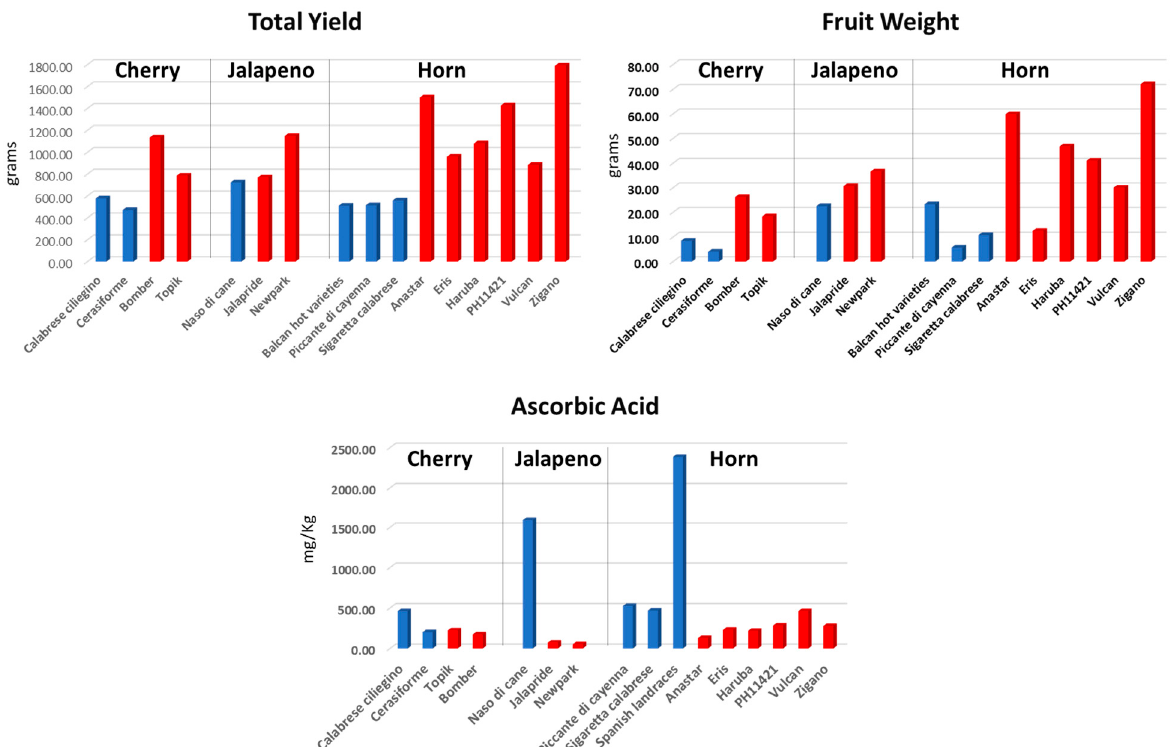
Figure 3. Bar graphs showing average values of total production, fruit weight and ascorbic acid content for the hybrids evaluated in this study (average of the two growing environments) compared with local cultivar investigations. For ‘Cal- abrese cherry’, ‘Cerasiforme’, ‘Piccante di Cayenna’ and ‘Cigaretta Calabrese’ the average values observed for the 2014–2016 seasons in the experimental fields of CREA of Battipaglia, Montanaso Lombardo and Monsampolo del Tronto [6,7,11] were considered. For the pungent cultivars from the Balkans, only the production data reported in [12] and related to the 2018–2019 seasons were considered. For Spanish cultivars, we considered the average ascorbic acid levels described in Rodríguez-Burruezo et al. [13]. All studies used the same method of assessment reporting values in the same scale.